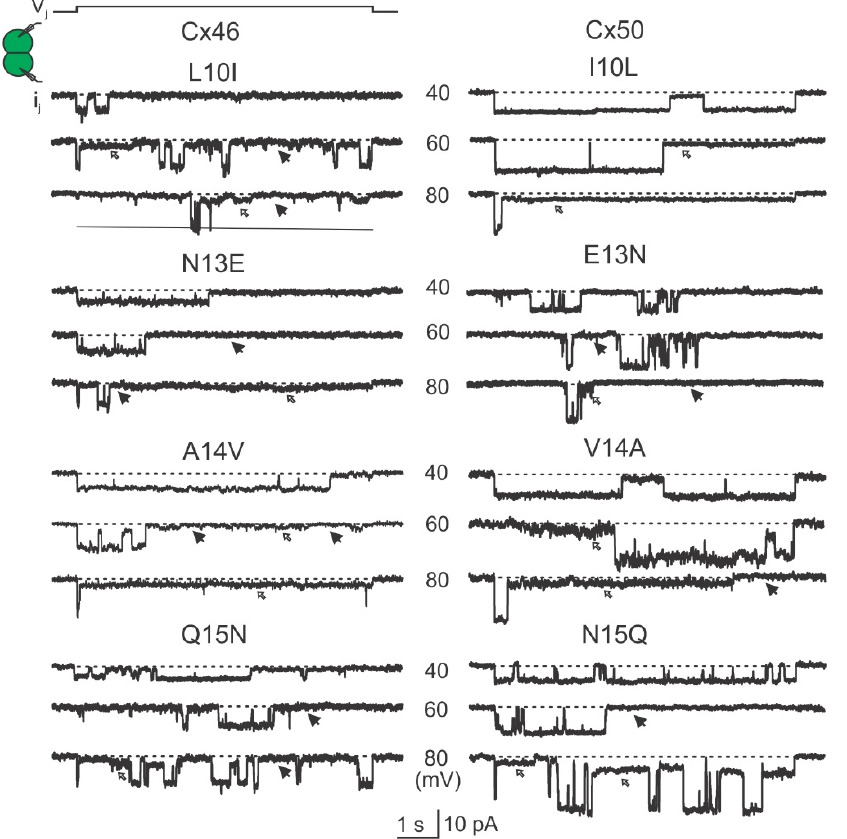
Figure 7. Single channel currents (i j s) recorded in response to the indicated V j s. Representative i j s are shown for the homotypic GJs formed by Cx46 NT variants (left panels) or Cx50 NT variants (right panels). In addition to the fully open state, subconductance (open arrows) and fully closed (solid arrows) states were also observed for some i j s.